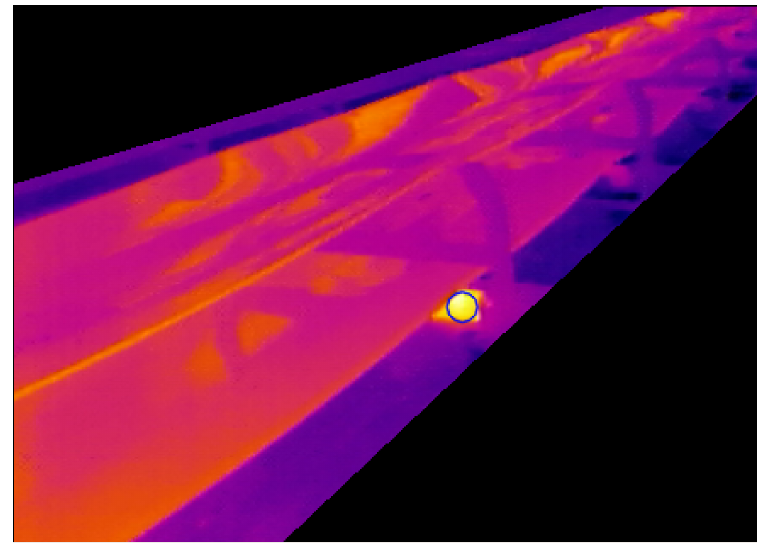
Figure 12. Result of damaged idler detection, example 1.